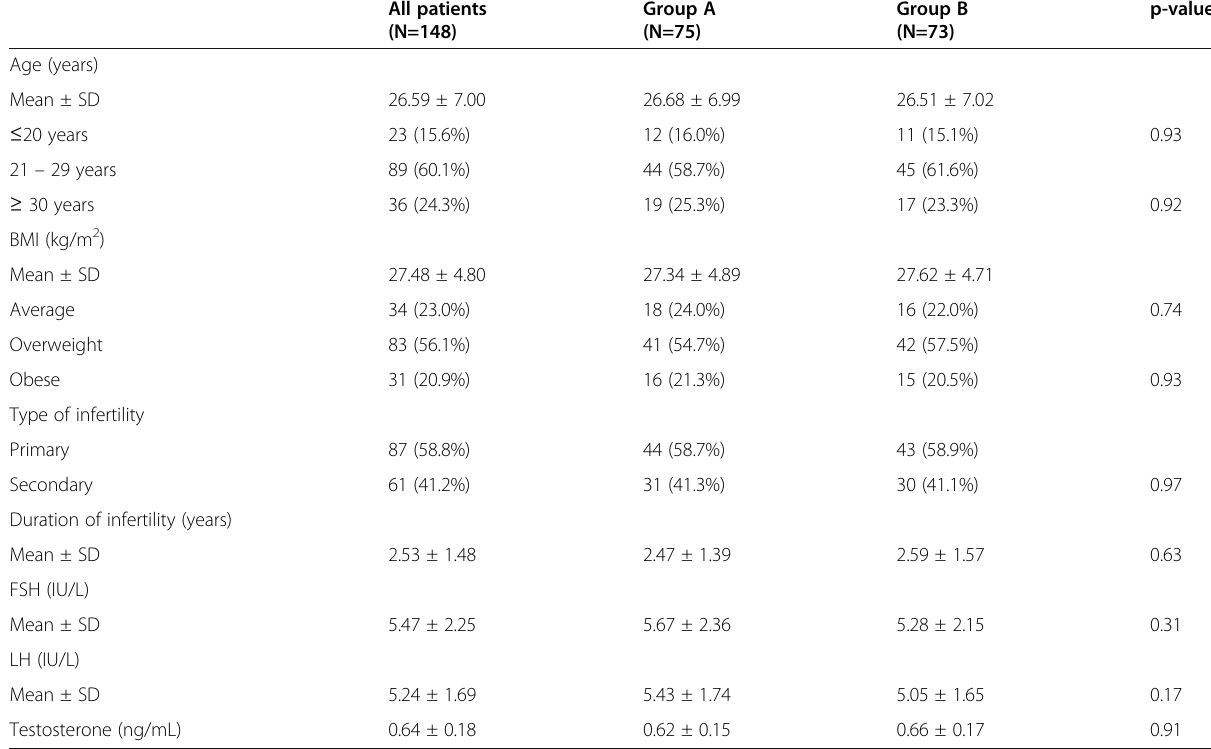
Table 1 Demographic and clinical data of the study